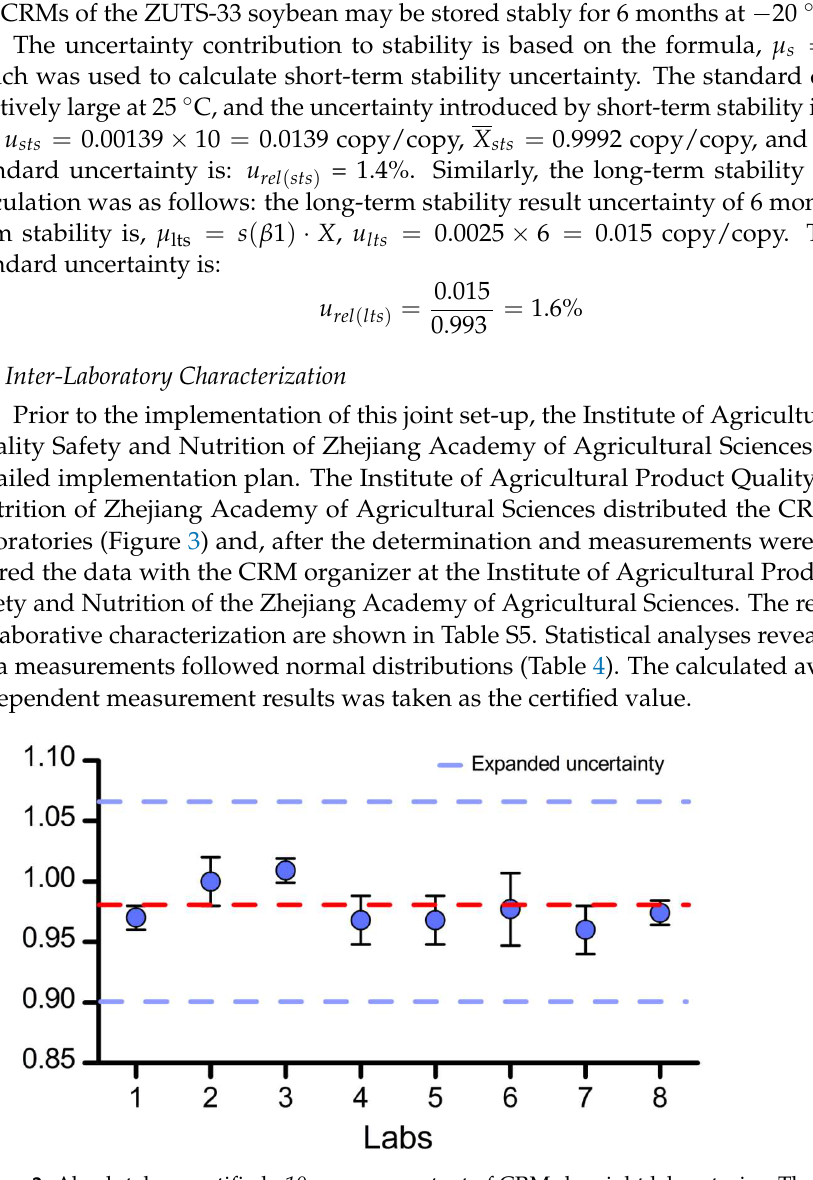
Figure 3. Absolutely quantified g10evo-epsps content of CRMs by eight laboratories. The dashed lines indicate the certified value (red) and range of the standard uncertainty (blue). Table 4. Results of inter-laboratory characterizations.